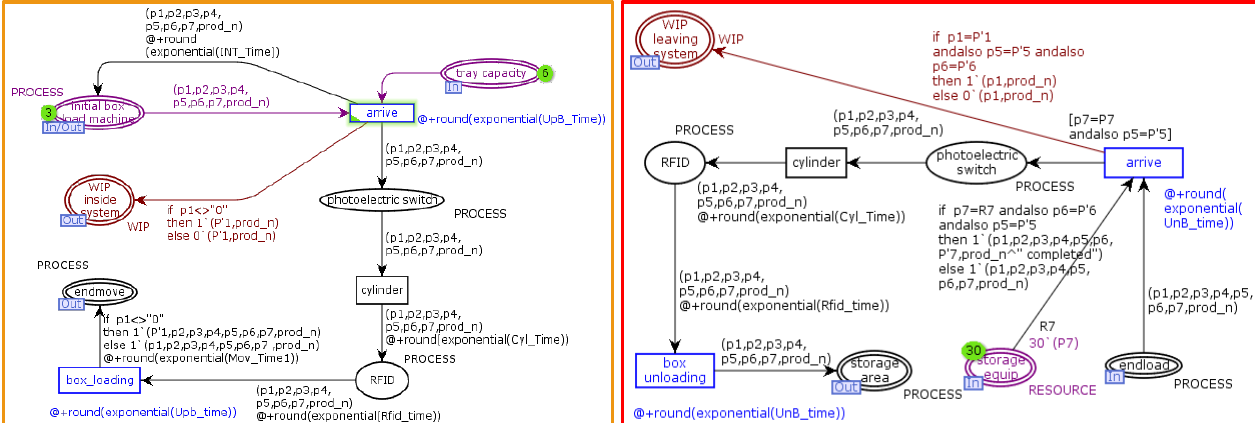
Figure 6. A snapshot of scenario “workstation layer” modelled on CPN